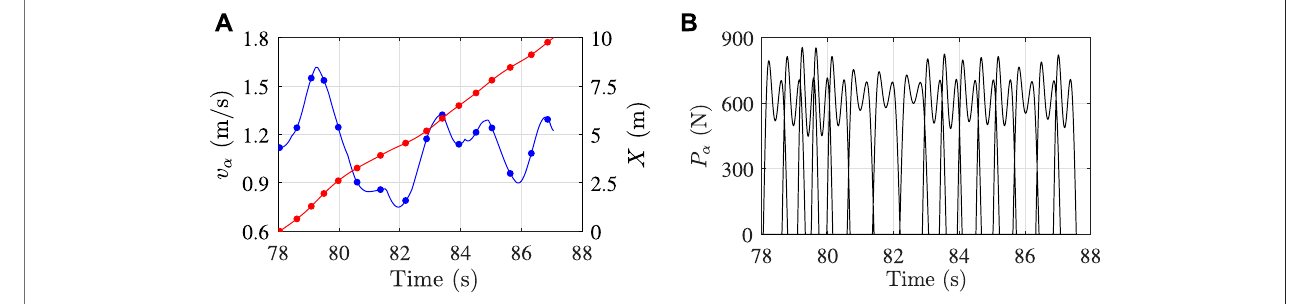
FIGURE 10 | Example of (A) pedestrian velocities (blue line and dots) and positions in X direction (red line and dots) vs. time and (B) consecutive footfall forces.